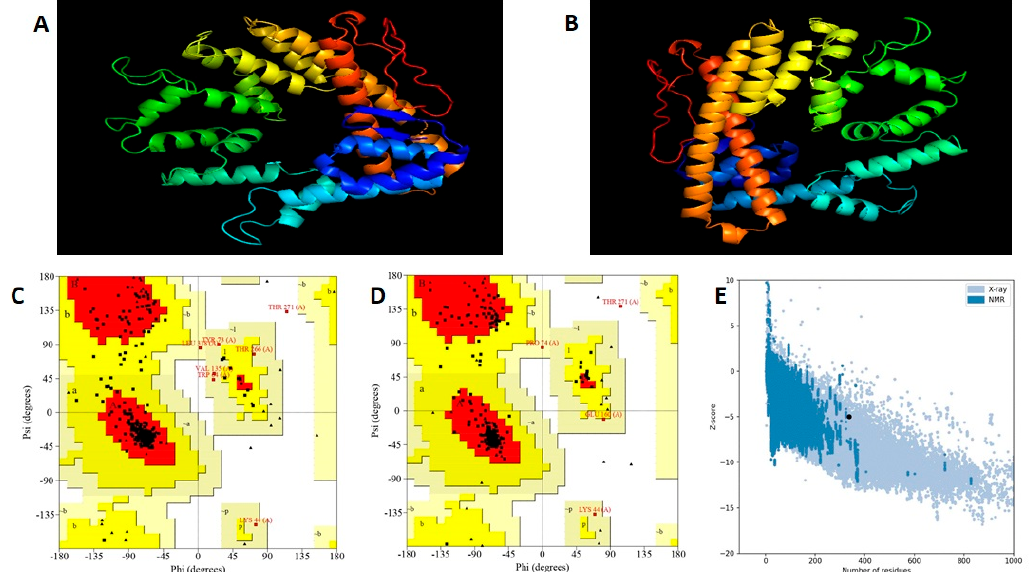
Figure 3. Vaccine construct 3D structure modelling, refinement and validation. ( A ) Tertiary structure of the vaccine construct using RaptorX. ( B ) Refined 3D model of the vaccine construct using Galaxy Refine. ( C ) Initial Ramachandran plot showing 87.2% residues in most favored regions, 12.5% residues in additional and generously allowed regions, and 0.4% residues in disallowed regions. ( D ) Ramachandran plot after refinement showing 92.1% in favor, 6.8% in allowed and 0.4% in disallowed regions of protein residues. ( E ) Z score of refined model using ProSA-web, showing a score of − 5.2.